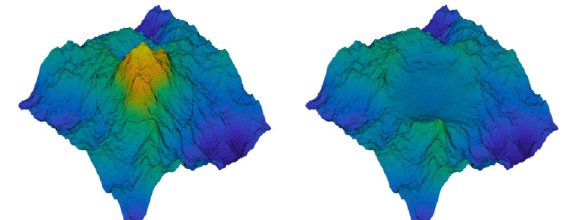
Fig. 5 Topography of a rough surface before and after detachment and disappearance of a wear particle.